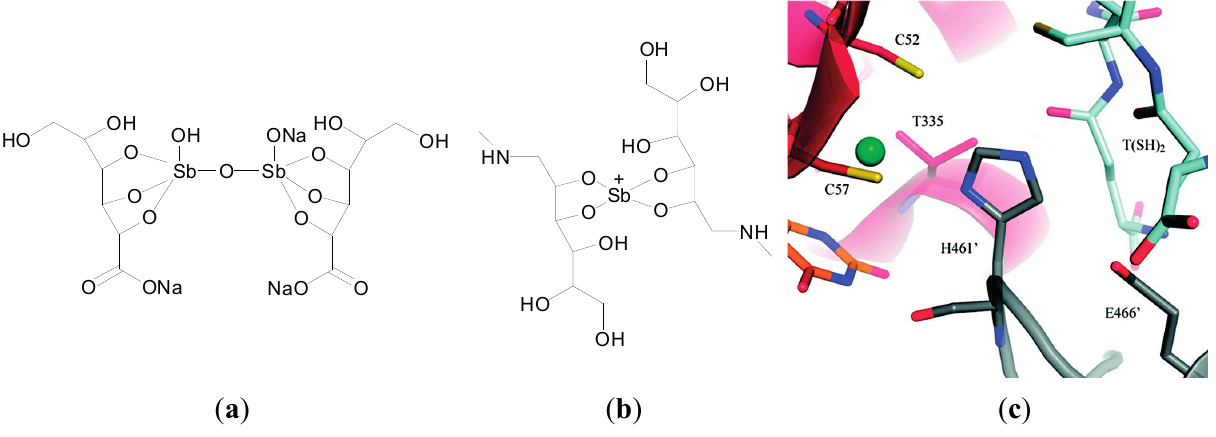
Figure 12. Structures of ( a ) sodium stibogluconate and ( b ) meglumine antimoniate; ( c ) Overall view of the catalytic cleft of trypanothione reductase (TR) with Sb(III) from T. Infantum (PDB code 2W0H). The residues involved in trypanothione reduction are indicated as sticks [109]. The trypanothione substrate, modelled on the basis of the T. cruzi TR structure (PDB code 1BZL), is also indicated as sticks and coloured cyan. Reprinted